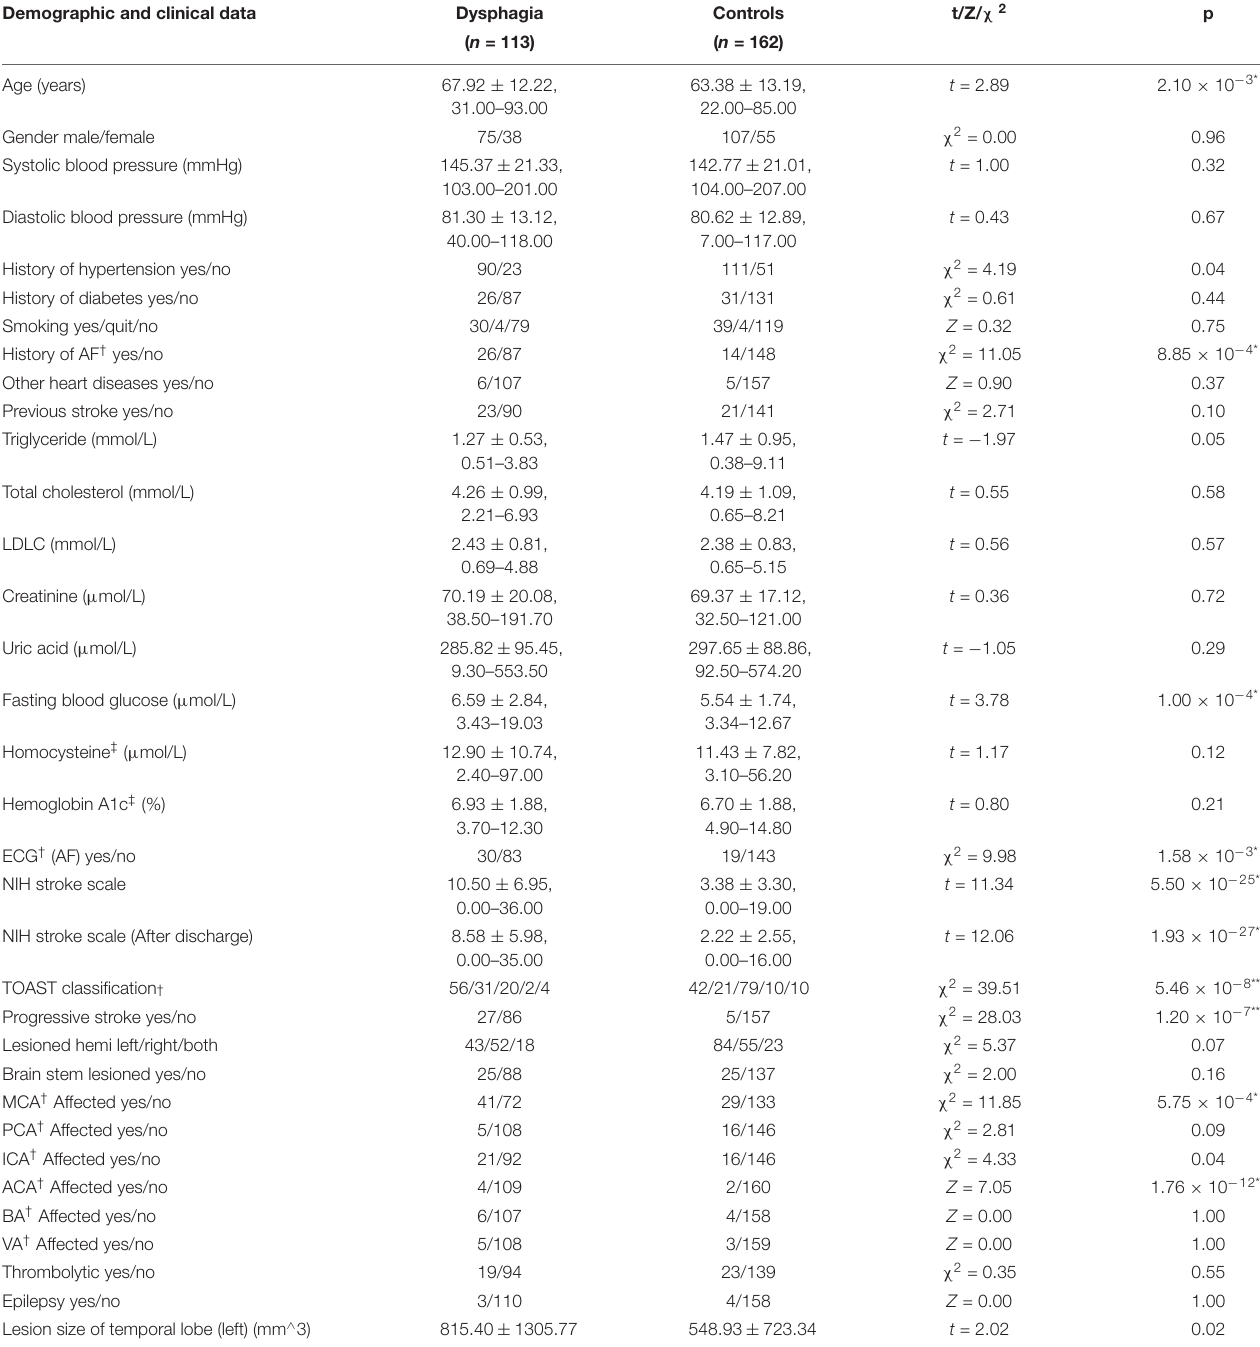
TABLE 1 | Demographic and clinical data of patients with dysphagia and